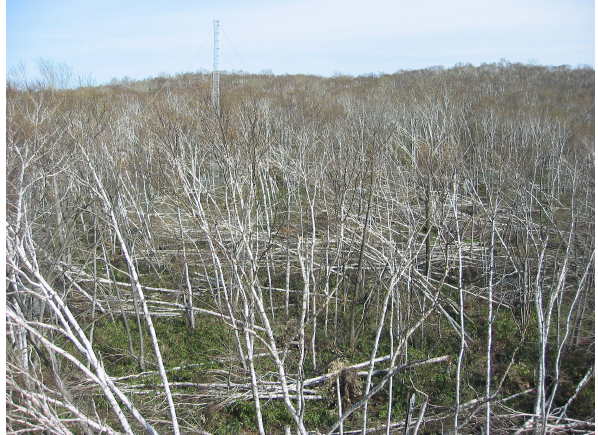
Figure 1. Southeast-facing aspect at a deciduous broadleaf forest in Sapporo, Japan. This forest was disturbed by strong wind in September 2004. The picture was taken on 12 May